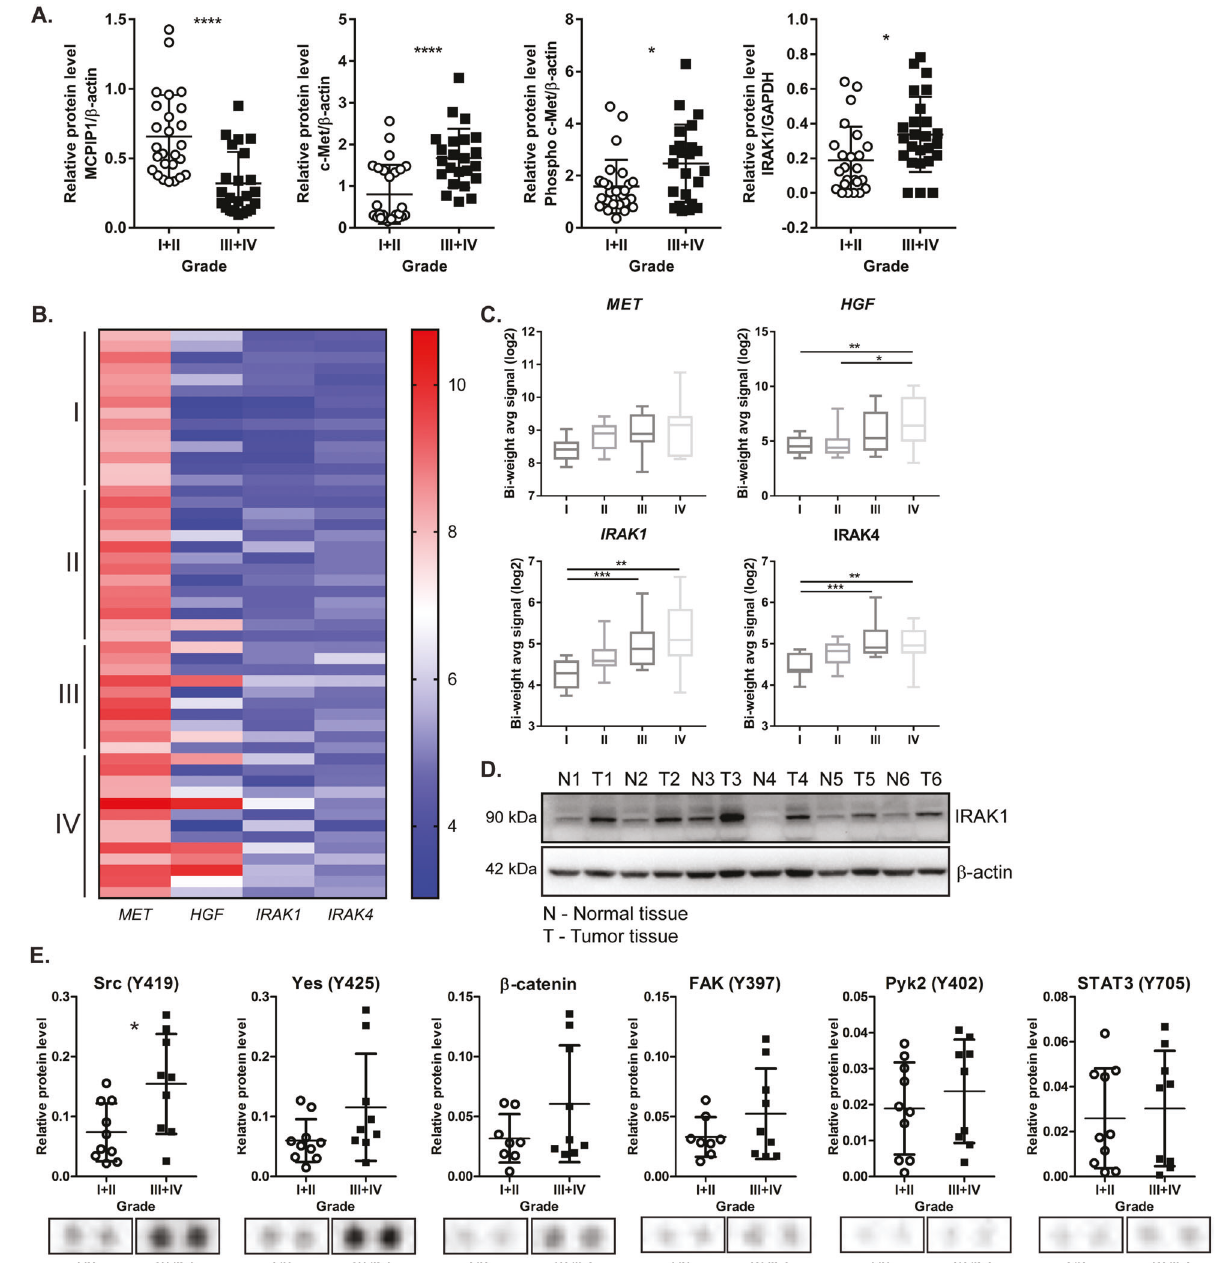
Fig. 8 The levels of MCPIP1, IRAK1, and c-Met receptor in tumor tissue samples from ccRCC patients. A Quanti fi cation of the protein level of 51 tumor samples (assessed by western blot), divided into four groups according to tumor grade. B Heatmap showing the correlation between western blot and microarray analysis from the same patient tissue samples. Each row represents an individual tissue sample. N I = 14, N II = 14, N III = 10, N IV = 13. C Quanti fi cation of the signal from microarray. Statistical analysis was performed using one-way ANOVA between subjects (unpaired) where N = 15 per group. D Western blot analysis of IRAK-1 in patient tissue samples (N - normal tissue; T - tumor tissue) with β -actin as a loading control. E Proteome-pro fi ler analysis from 20 patient tissue samples ( N = 5 per each group, except group III where N = 4). Each dot from the arrays represents one sample from grade I/II and grade III/IV patient tumor. P values were estimated using two-tailed unpaired Student ’ s t test. * P < 0.05; ** P < 0.01; *** P < 0.001; **** P <